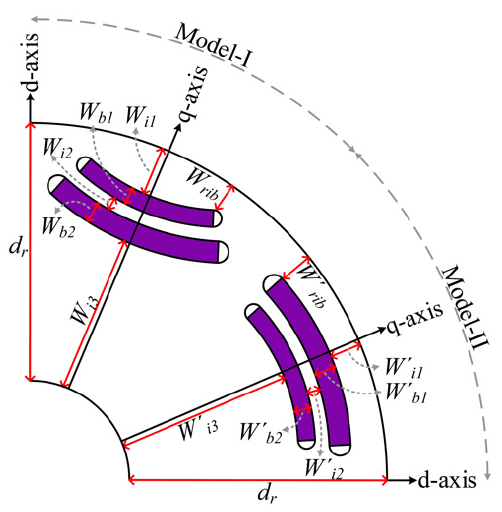
Figure 5. Main Design Parameters of the Rotor. Table 2. Rotor Design Parameters.